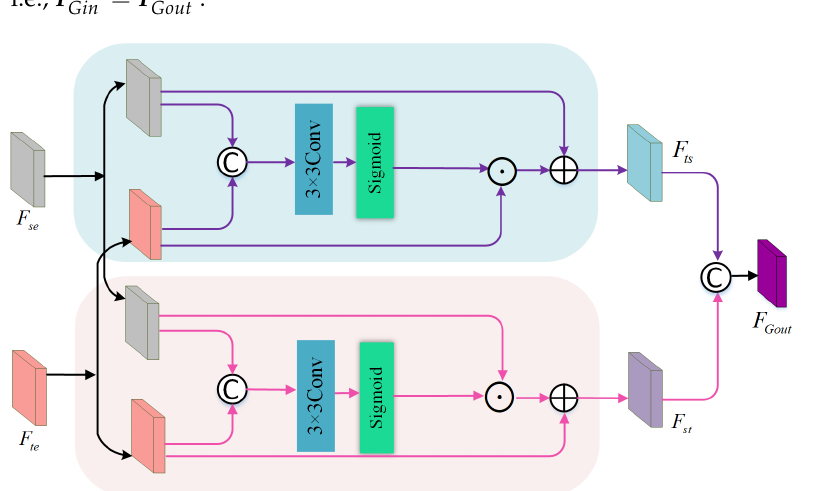
Figure 3. Cross-fusion